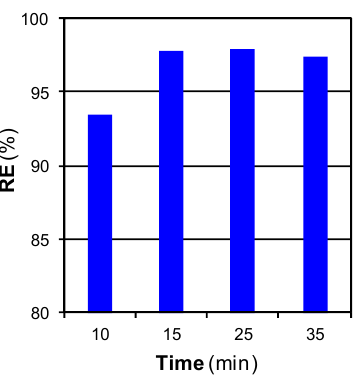
Figure 6. Effect of time on RE for regeneration at 100 bar and 250 °C with a SCCO 2 flow of 3 cm 3 · min − 1 .